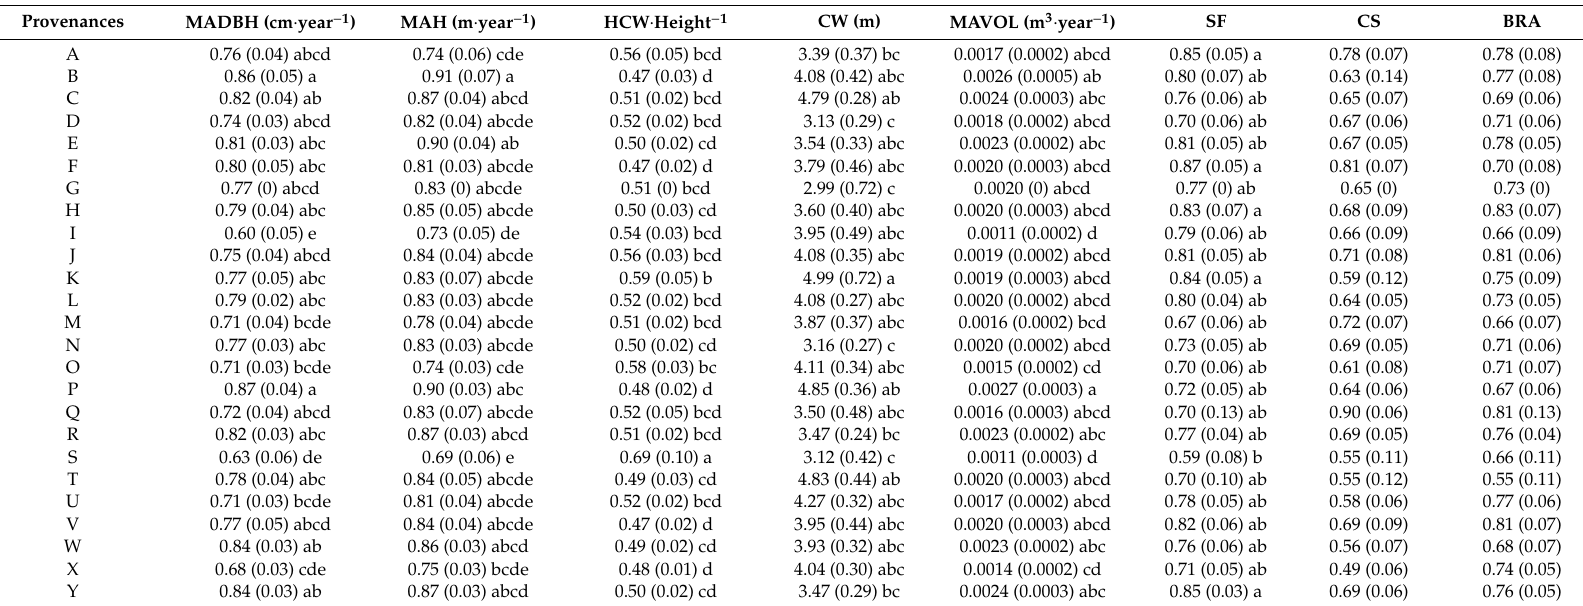
Table A5. Growth and quality traits for 25 provenances of Betula alnoids at Changning